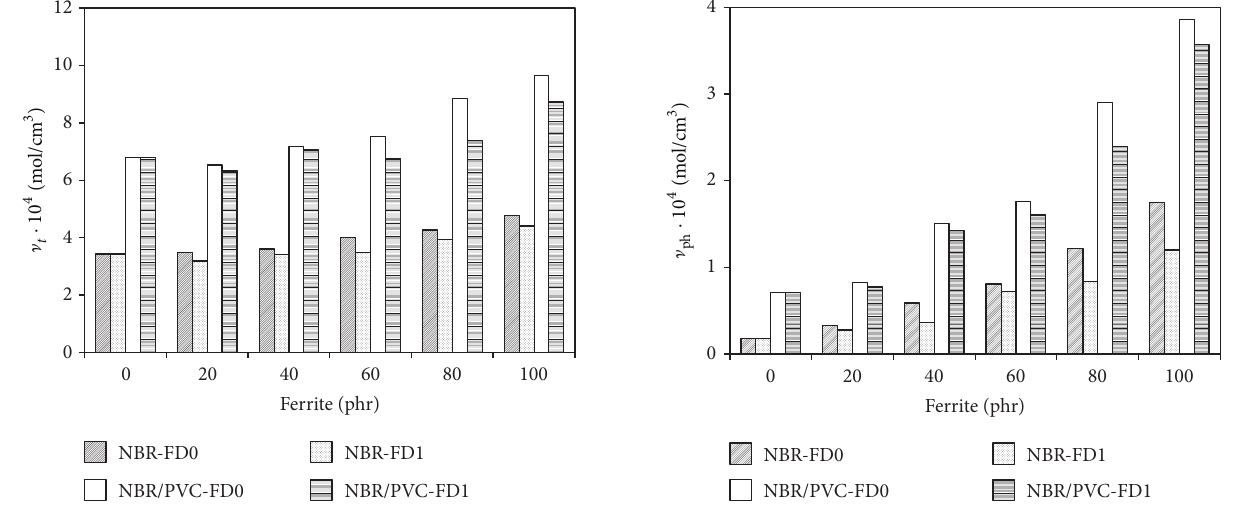
Figure 6: Influence of ferrites content on physical cross-link density ] ph of